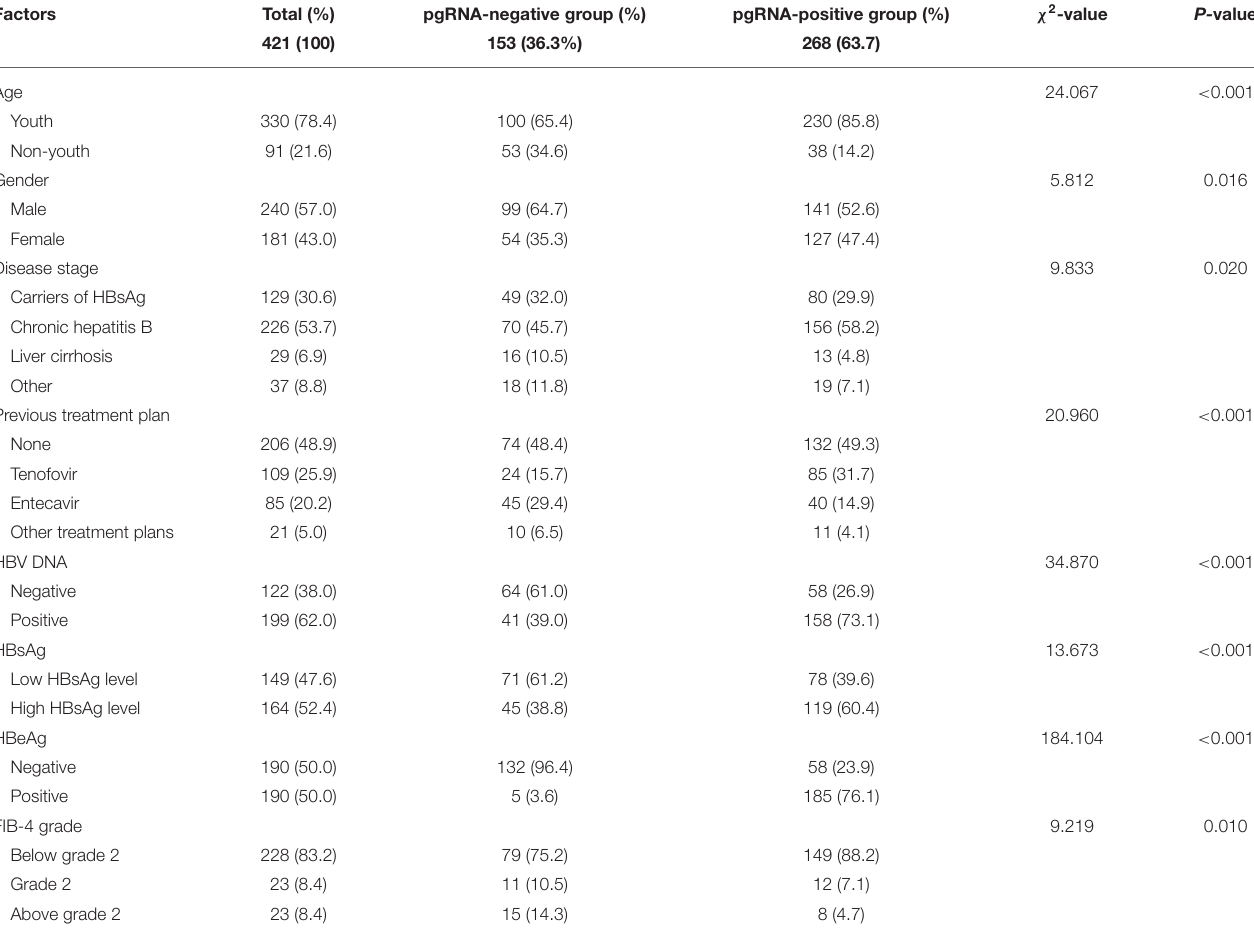
TABLE 1 | Description and difference analysis of factors under different pgRNA